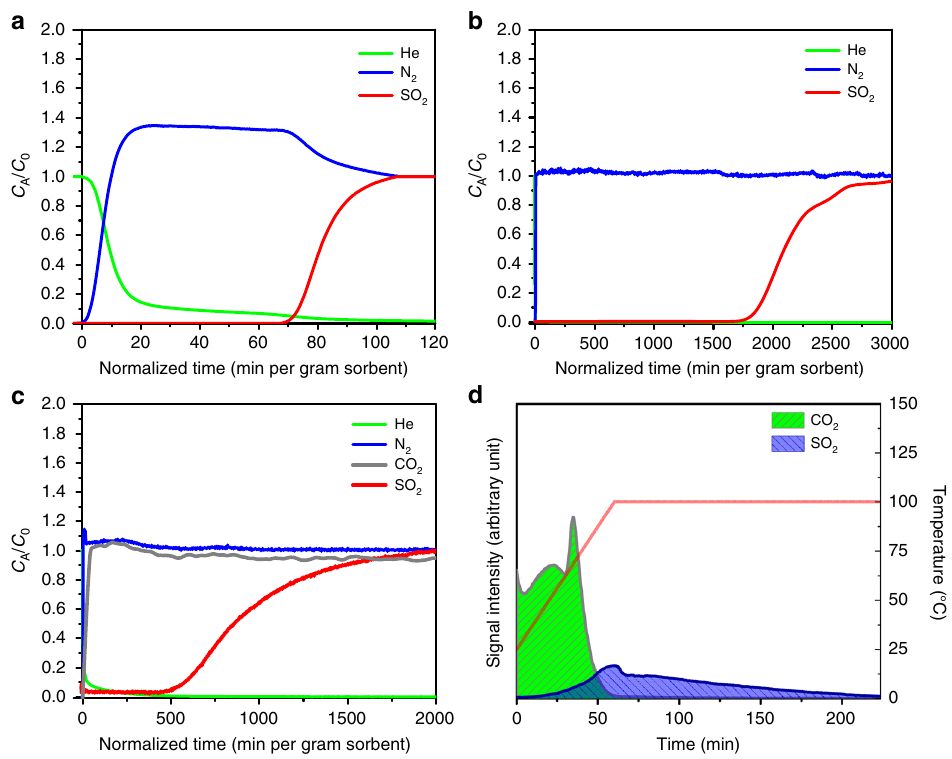
Fig. 4 CO 2 /SO 2 capture performance of KAUST - 8. Adsorption column breakthrough experiments for KAUST - 8 with a SO 2 /N 2 : 7/93 (10 cm 3 min − 1 , fl ow rate), b SO 2 /N 2 : 0.05/99.95 mixture (40 cm 3 min − 1 , fl ow rate), and c SO 2 /CO 2 /N 2 : 0.05/10/89.95 (40 cm 3 min − 1 , fl ow rate). d TPD experiment suggests a considerable amount of SO 2 along with CO 2 as adsorbed phase after a breakthrough experiment with 500 p.p.m. SO 2 in the presence of 10% CO 2 and balance N 2